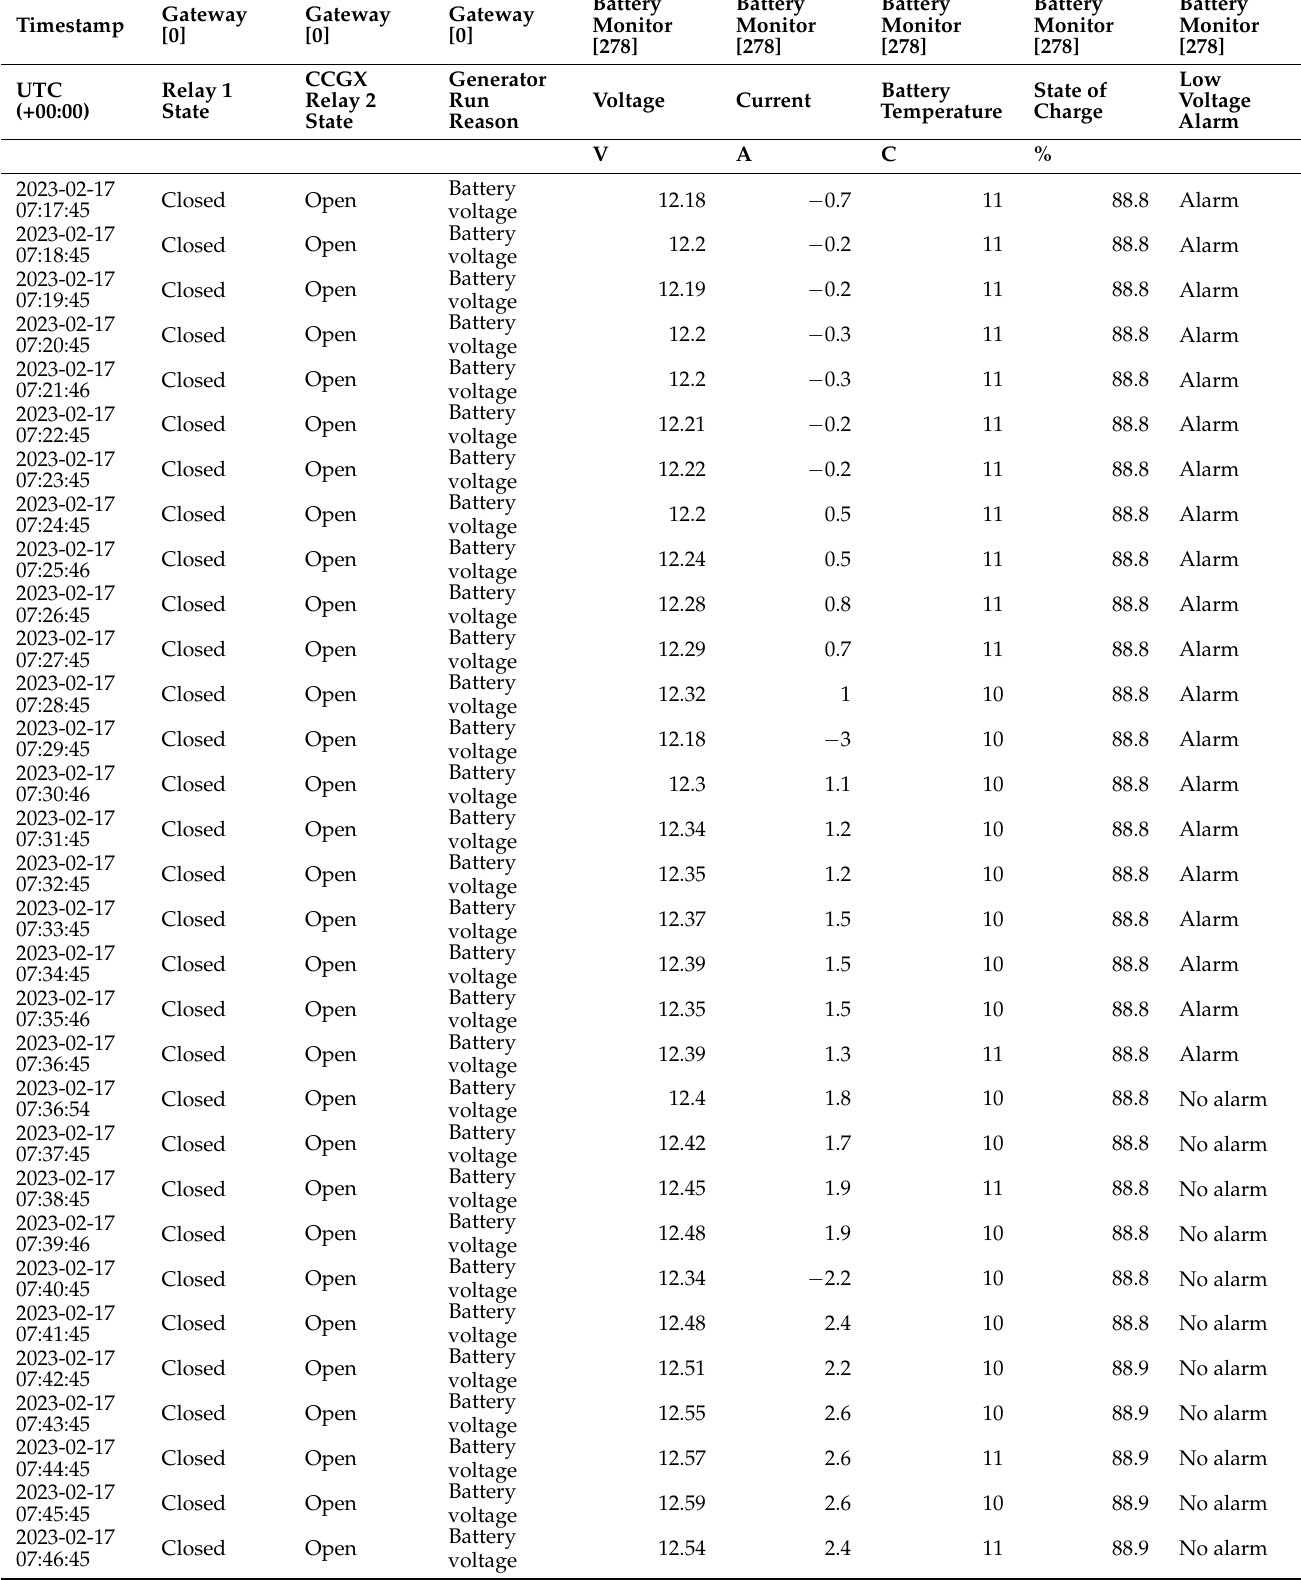
Table 2. Test based on voltage, current, and SOC conditions to start/stop solar